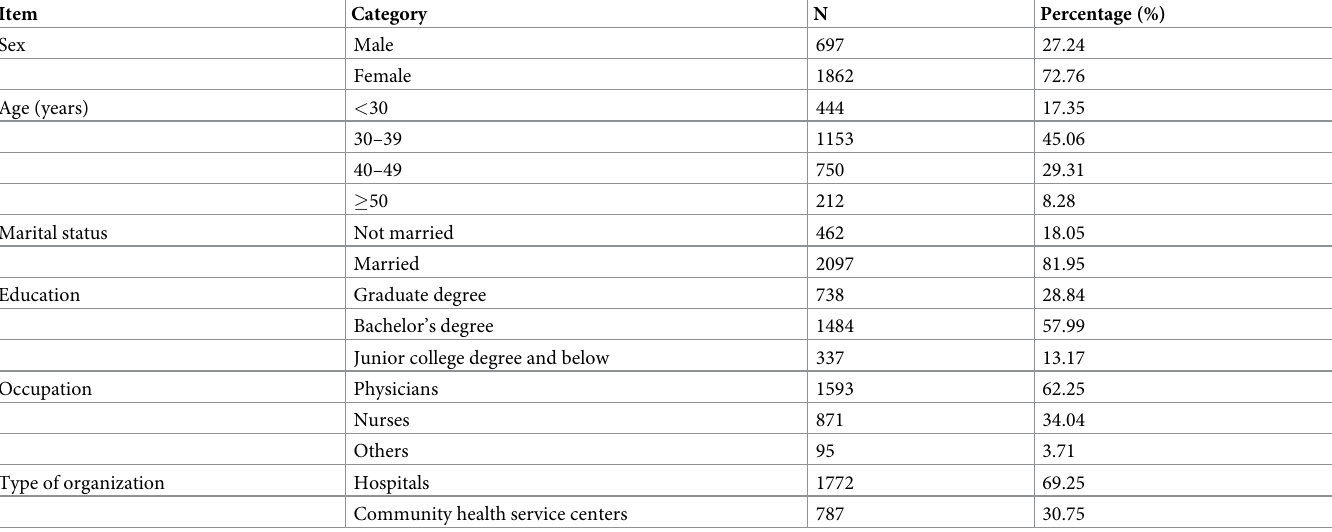
Table 1. Demographic information for the study sample of Shanghai medical workers in Shanghai,